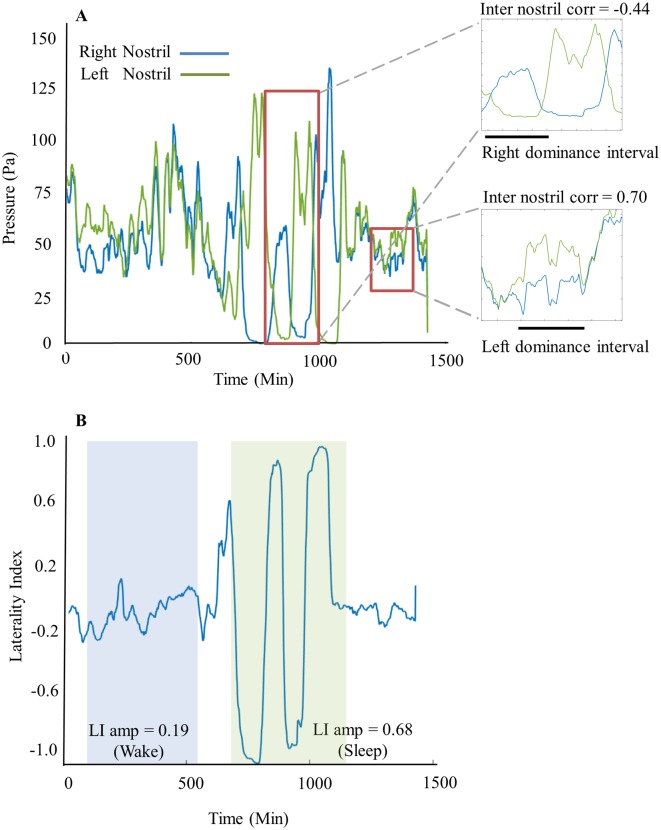
Example of processed data from a typical subject.(A) Average filtered nasal airflow peaks over time for right (blue) and left (green) nostrils (smoothed with a 20 minute window for display). Large red rectangle highlights a portion of sleep with right dominance indicated by black bar and negative inter nostril correlation (r = -0.44). Small red rectangle highlights a portion of wake with left dominance indicated by black bar and positive inter nostril correlation (r = 0.7). (B) Laterality index graph calculated and aligned for the data presented above. Light blue shading highlights low LI amplitude in wake (mean = 0.19) and light green highlights high amplitude in sleep (mean = 0.68).